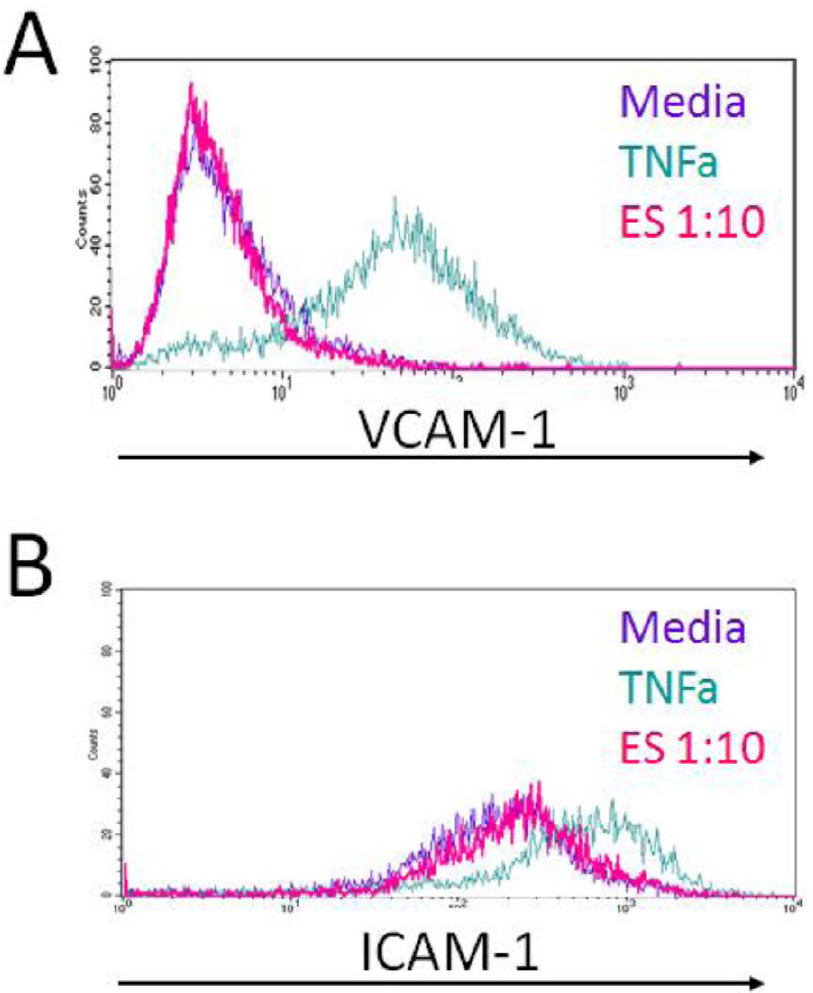
Figure 4. Surface expression of adhesion molecules in response to worm ES products. LECs were grown to confluence in EGM-2MV media then cells were stimulated for 24 hours in EGM-2MV media with or without ES (1:10) or TNF a (10 ng/mL). LECs were harvested and subjected to flow cytometry analysis for the expression of ICAM-1 or VCAM-1. This figure includes representative data from one experiment.